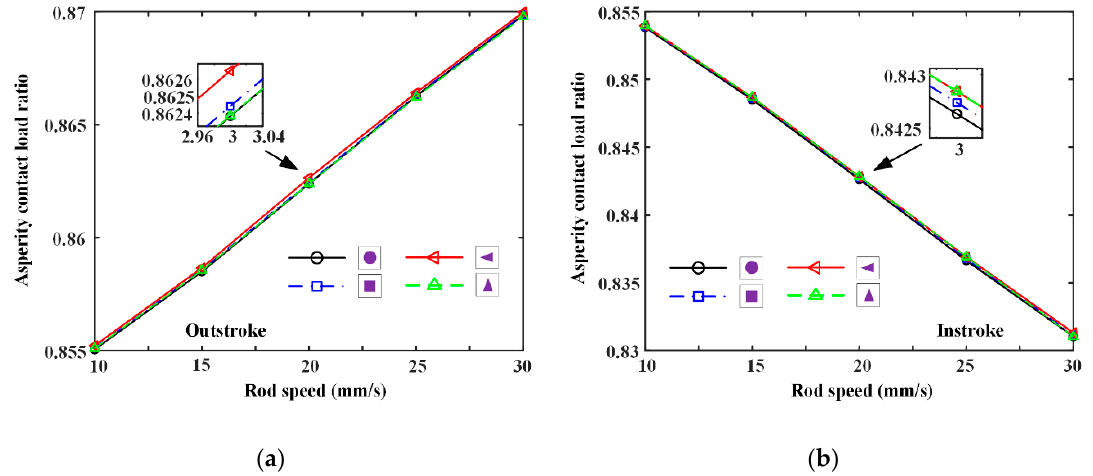
Figure 18. The relationship between the rod speeds and asperity contact load ratios, (a) outstroke, (b) instroke.